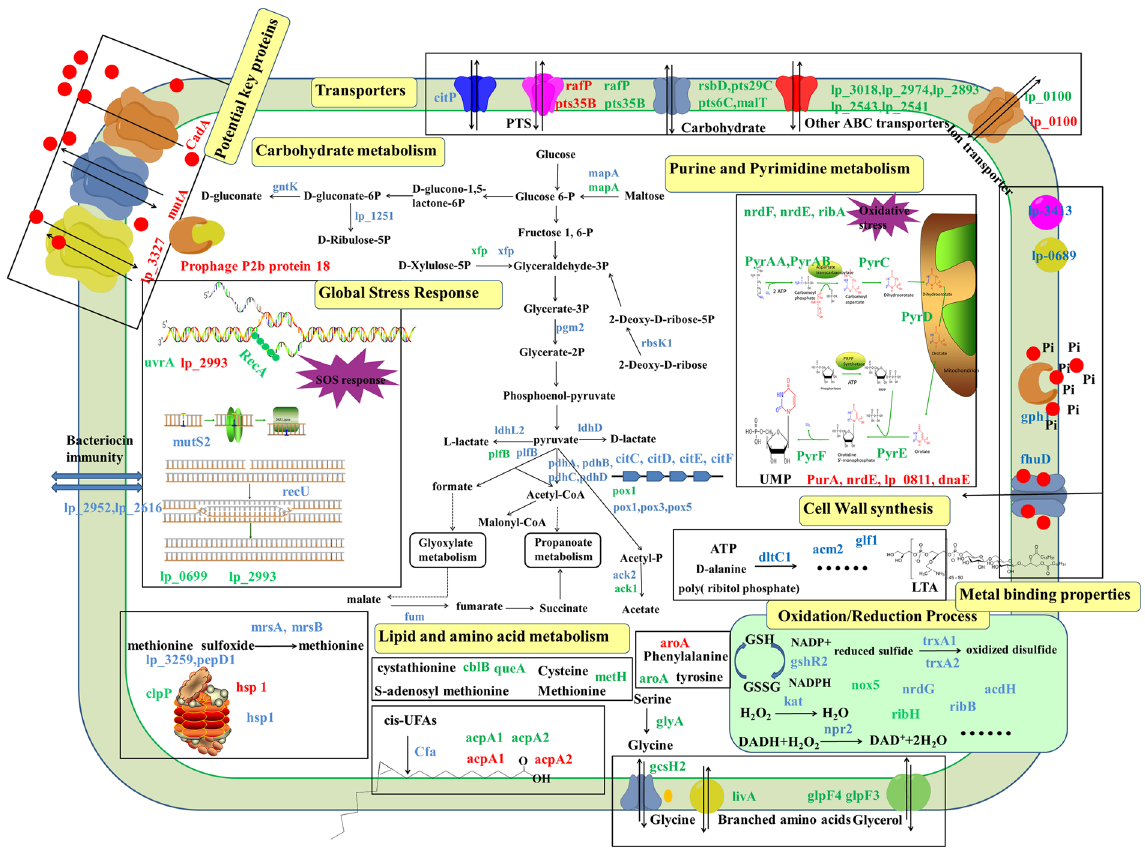
Figure 6. Proposed model for response mechanisms of CCFM8610 to Cd stress. Altered proteins (fold change > 1.5 or <− 1.5 and P < 0.05) in three comparisons of CCFM8610(0)/CCFM191(0), CCFM8610(Cd)/ CCFM8610(0) and CCFM191(Cd)/CCFM191(0) are presented in the color of blue, red and green, respectively. Red dots represent Cd